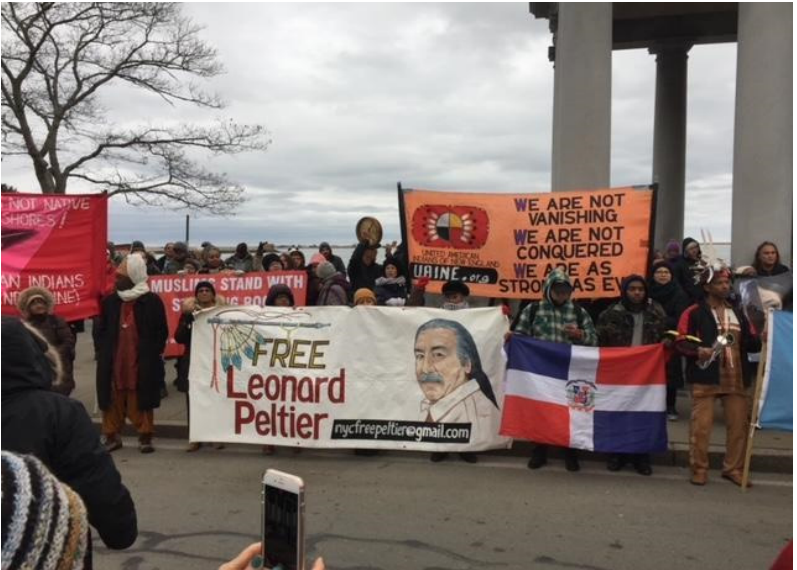
Figure 5. Urban Atabex community at National Day of Mourning at Plymouth Massachusetts. 22 November 2018. Standing in solidarity with political prisoner Leonard Peltier (Leonard Peltier is an Indigenous freedom fighter political prisoner. Please learn more about him here: https://www. whoisleonardpeltier.info/) (accessed on 4 February